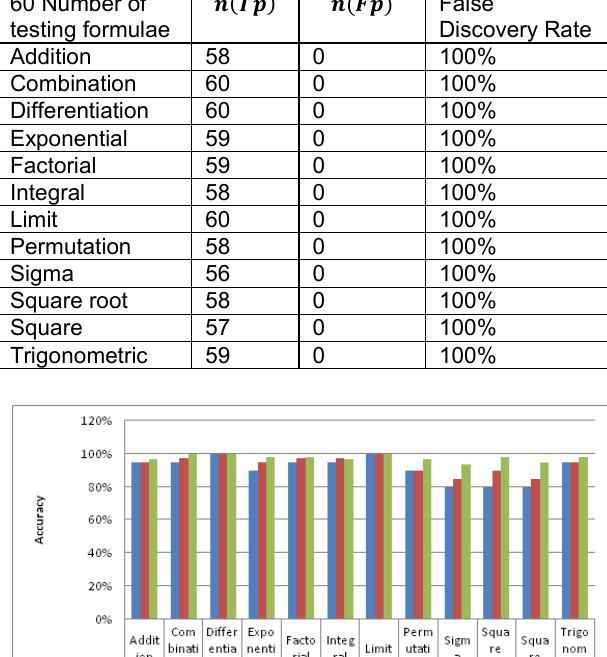
Table 24. The above tabulated value represents overall PPV Measure with Tensorflow from a document of 60 samples.